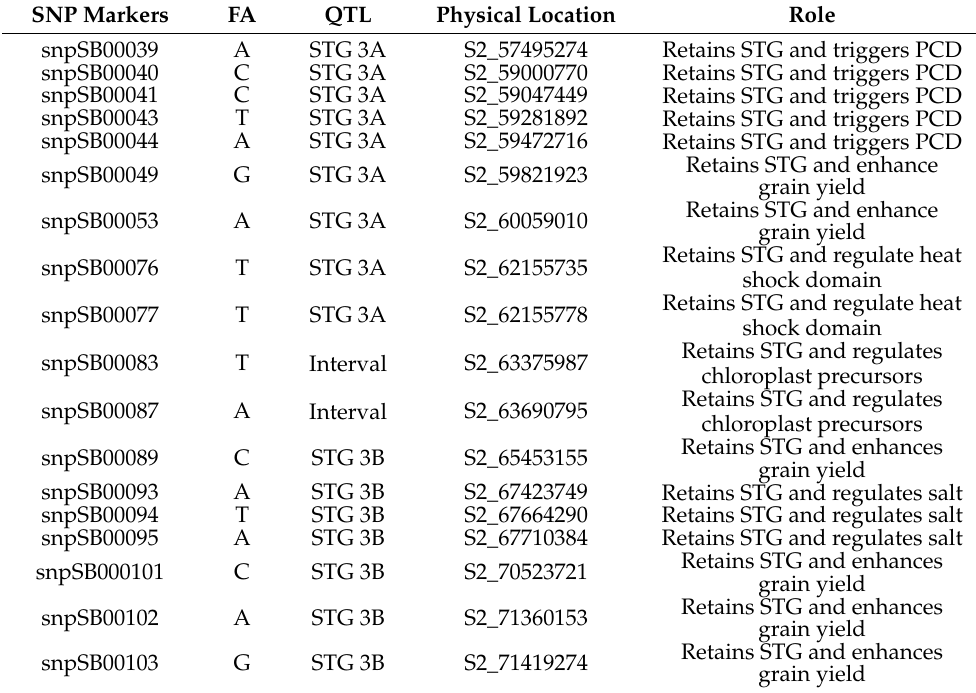
Table 4. Favourable alleles and STG QTLs identified after genotyping BC 2 F 1 populations of sorghum. SNP